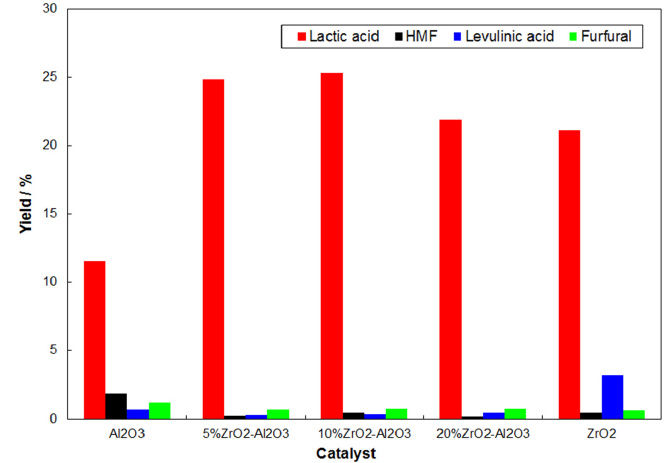
Figure 2. Product yields obtained by using Al 2 O 3 , ZrO 2 , or ZrO 2 –Al 2 O 3 mixed ‐ oxide catalysts for the conversion of cellulose to lactic acid. Reaction conditions: ball ‐ milled cellulose, 0.5 g; catalyst, 1.0 g; water, 50 g; reaction temperature, 473 K; reaction time, 6 h. HMF, 5 ‐ hydroxymethylfurfural.